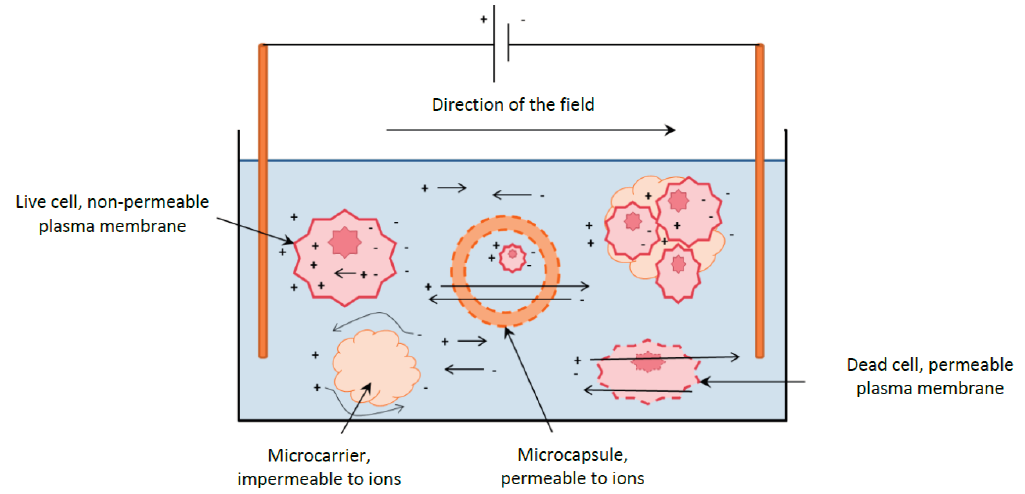
Figure 5. Schematic representation showing charge migration within a cell suspension when an electrical current is applied. The positive charge migrates towards the negative electrode and the negative charge towards the positive electrode. Unlike cell debris and solid particles, intact cells entrap ions which consequently polarize them.